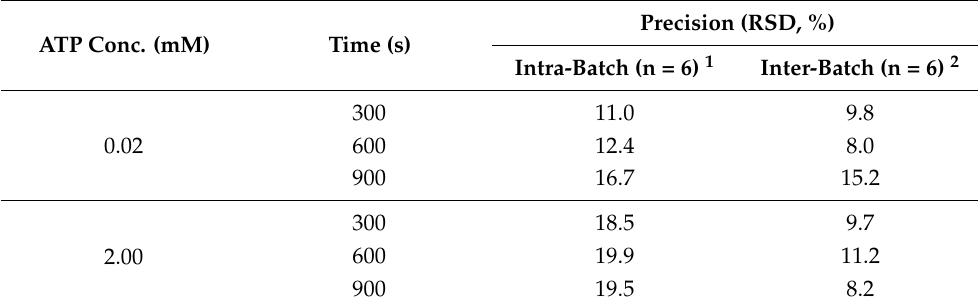
Table 1. Precision studies for paper biosensors obtained with different acquisition times (300, 600 and 1200